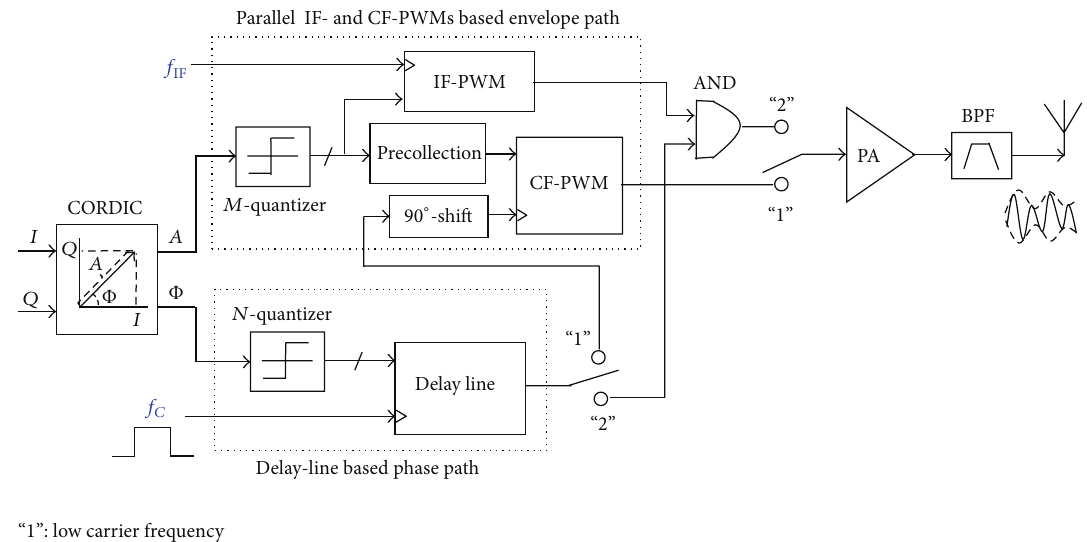
Figure 1: Proposed fully digital transmitter with parallel IF- and